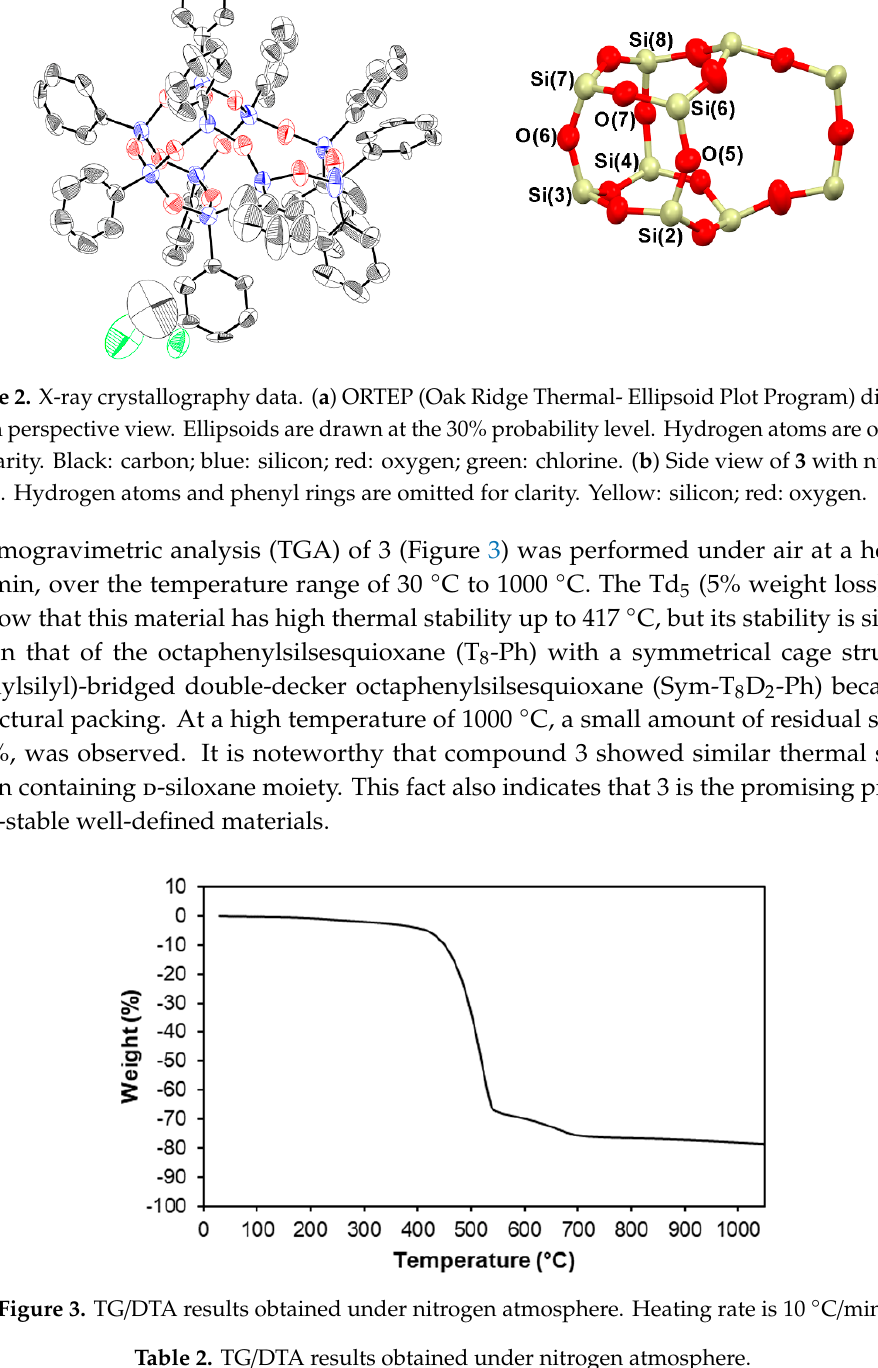
Figure 3. TG/DTA results obtained under nitrogen atmosphere. Heating rate is 10 °C/min. Figure 3. TG / DTA results obtained under nitrogen atmosphere. Heating rate is 10 ◦ C / min. Table 2. TG / DTA results obtained under nitrogen Table 2. TG/DTA results obtained under nitrogen atmosphere.